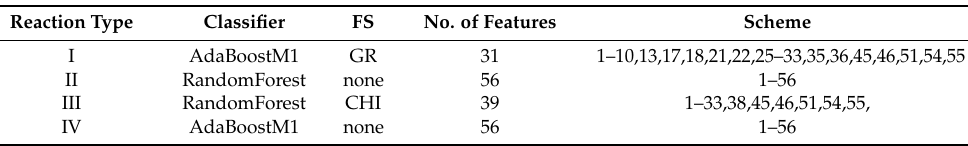
Figure 1. Four series of models for N -dealkylation. Here, CHI, GR, IG, and Relief represent models established based on CHI, GR, IG, and Relief FS techniques, respectively. Plots to compare different combinations of FS algorithms and classification algorithms, where both the accuracy (ACC) and area under curve (AUC) derived from 10-fold cross-validation are plotted as functions of the number of selected features. Different classification methods were characterized with different colors. Table 1. Optimal models selection results.